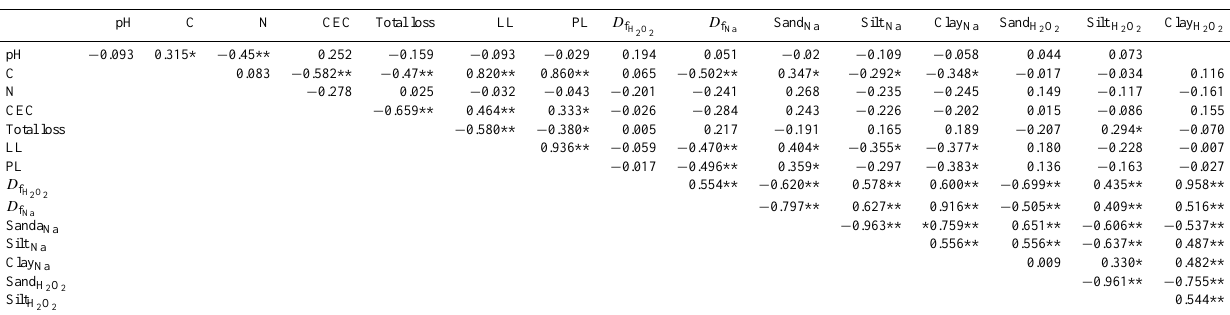
Table 5. Correlation matrix between soil properties, subsoils (* significant for p < 0.05; ** p < 0.01). pH C